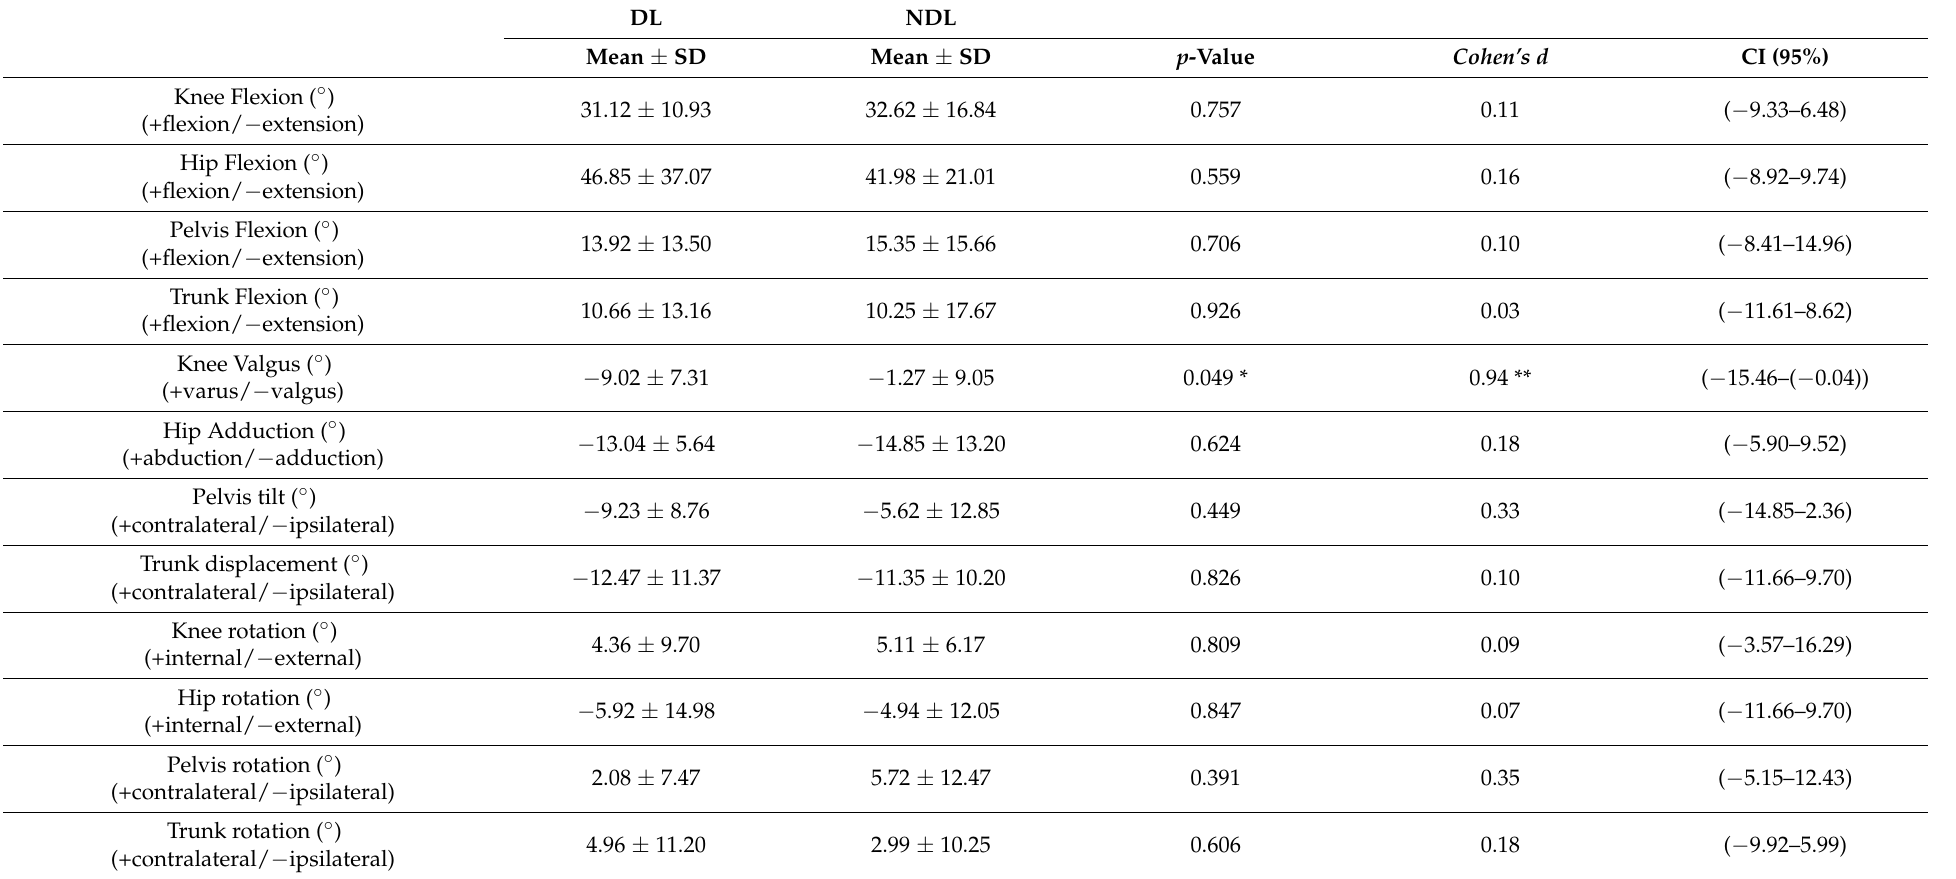
Table 2. Comparative analysis of the kinematic outcomes between the DL and the NDL in the whole